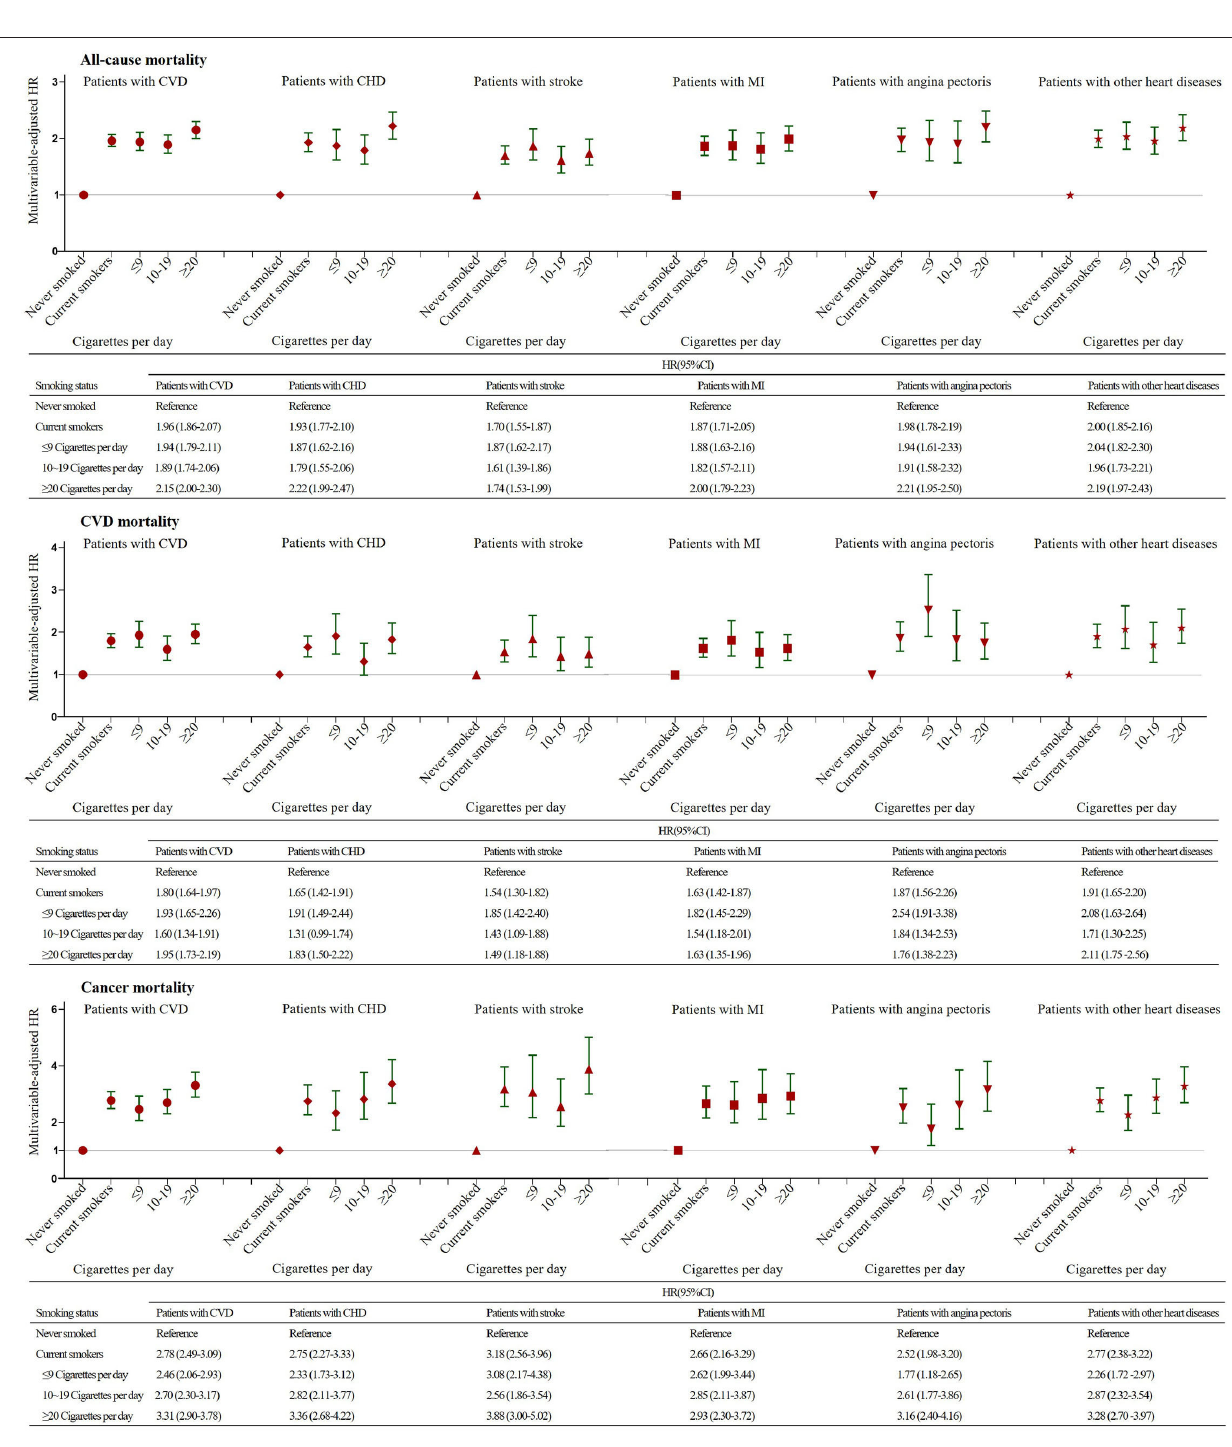
FIGURE 2 | Association of Smoking Intensity with All-cause, CVD and Cancer Mortality Stratified by the Presence of Cardiovascular Disease. The multivariable-adjusted model was adjusted for age, sex, race, education, income, body mass index, physical activity, alcohol intake, baseline hypertension, diabetes and cancer variables. CI, confidence interval; HR, hazard ratio; CVD, cardiovascular disease; CHD, coronary heart disease; MI, myocardial infarction.